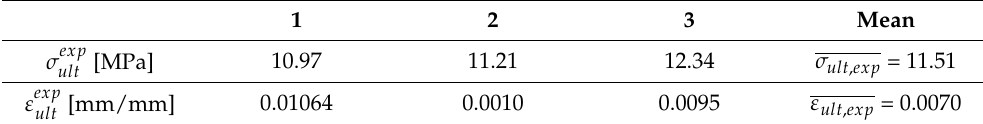
Table 4. Ultimate tensile stress and the corresponding tensile strain of three uniaxially loaded specimens.